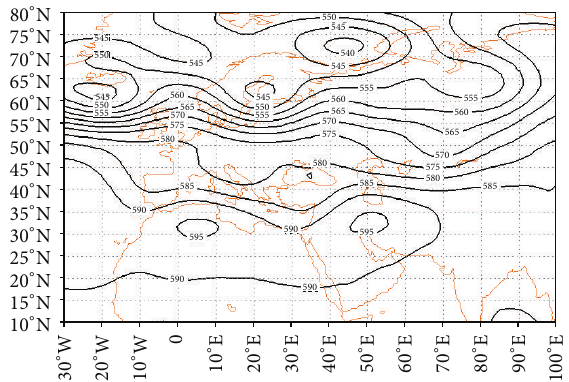
Figure 32: Geopotential elevation map at level 500 HPa in the representative day of pattern D.